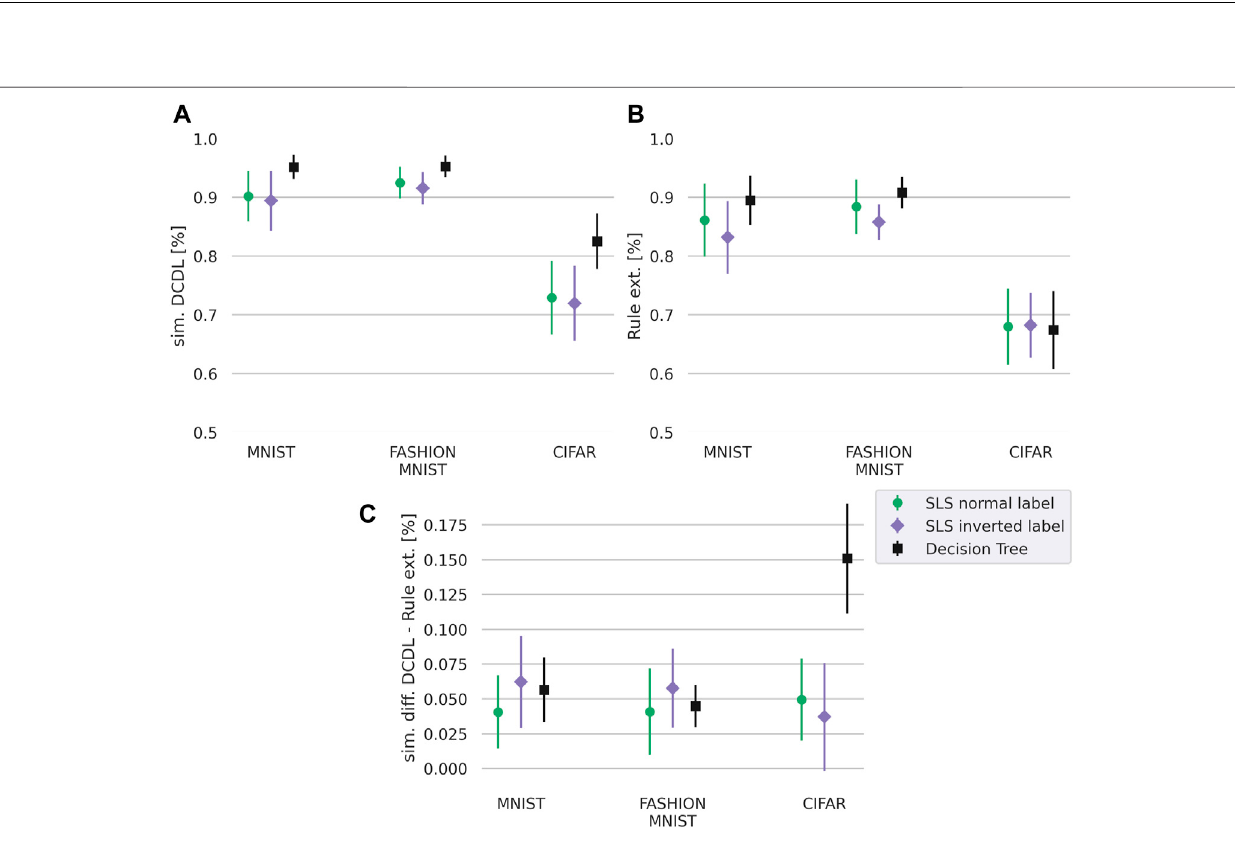
Frontiers in Arti fi cial Intelligence |